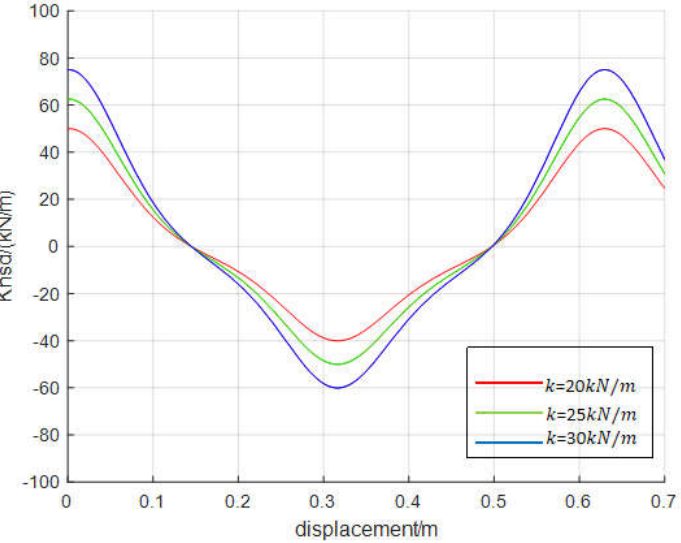
Figure 10. Effect of spring stiffness on negative stiffness.